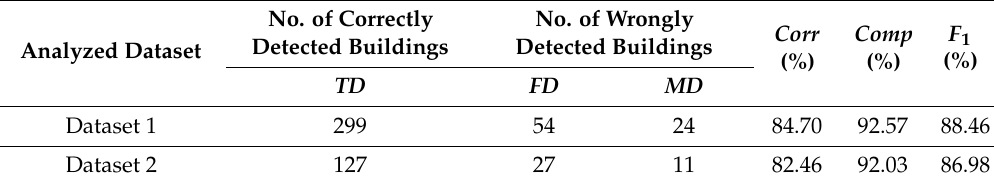
Table 3. The object-level performance of building change detection.